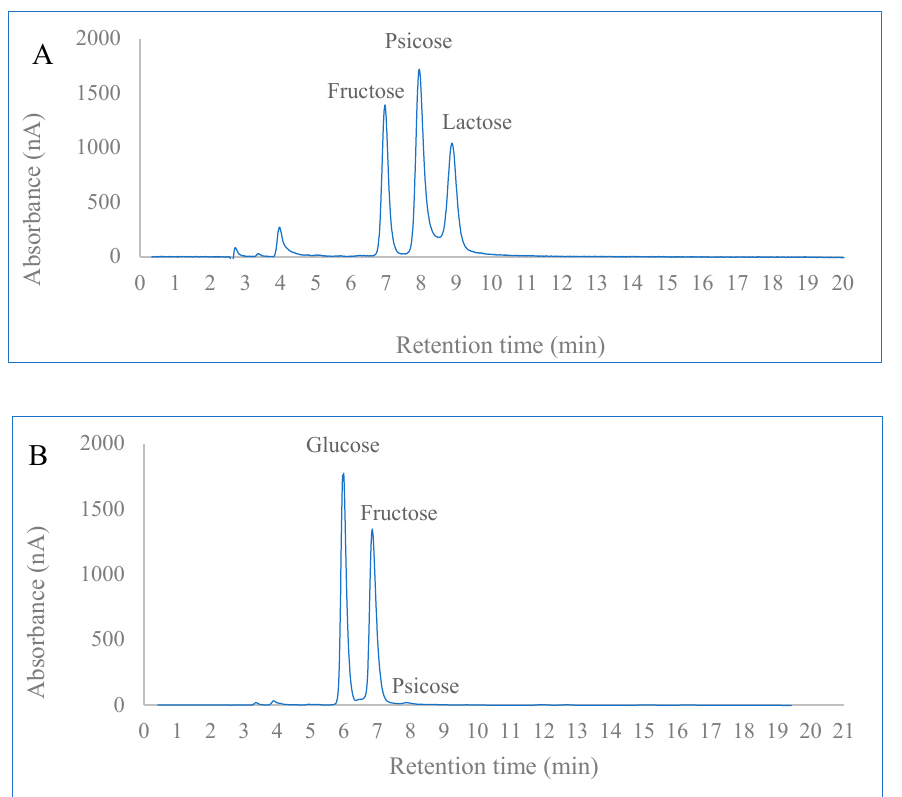
Five levels of psicose concentration (1.0, 2.5, 5.0, 7.5, and 10 mg L − 1 ) in triplicate were